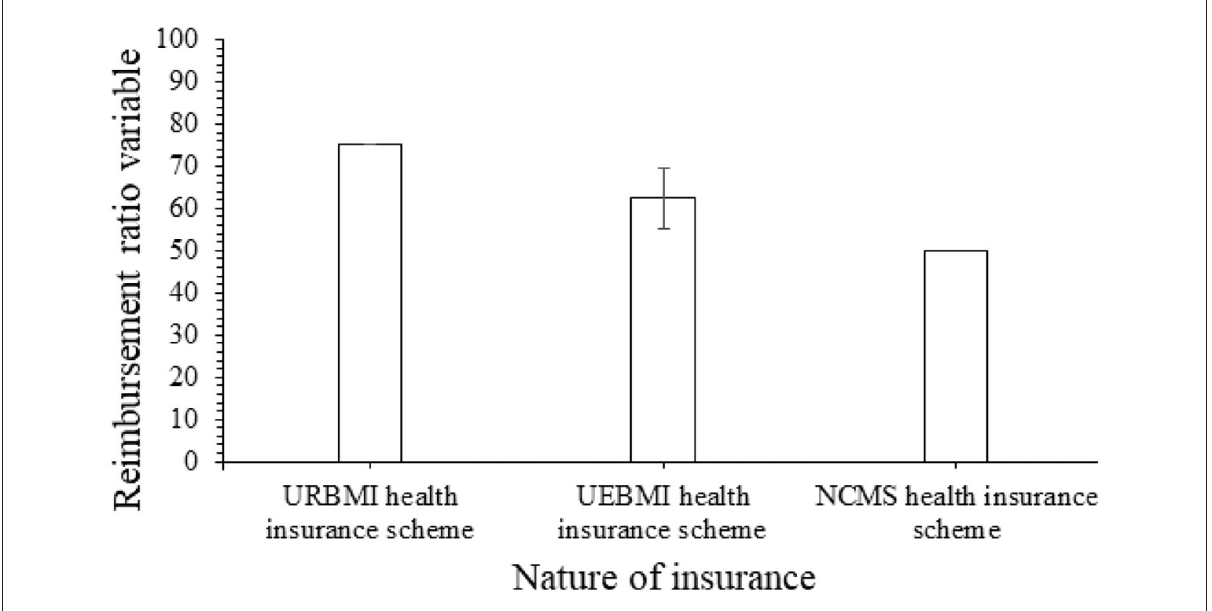
FIGURE3 The reimbursement ratio varies according to the nature of the insurance.